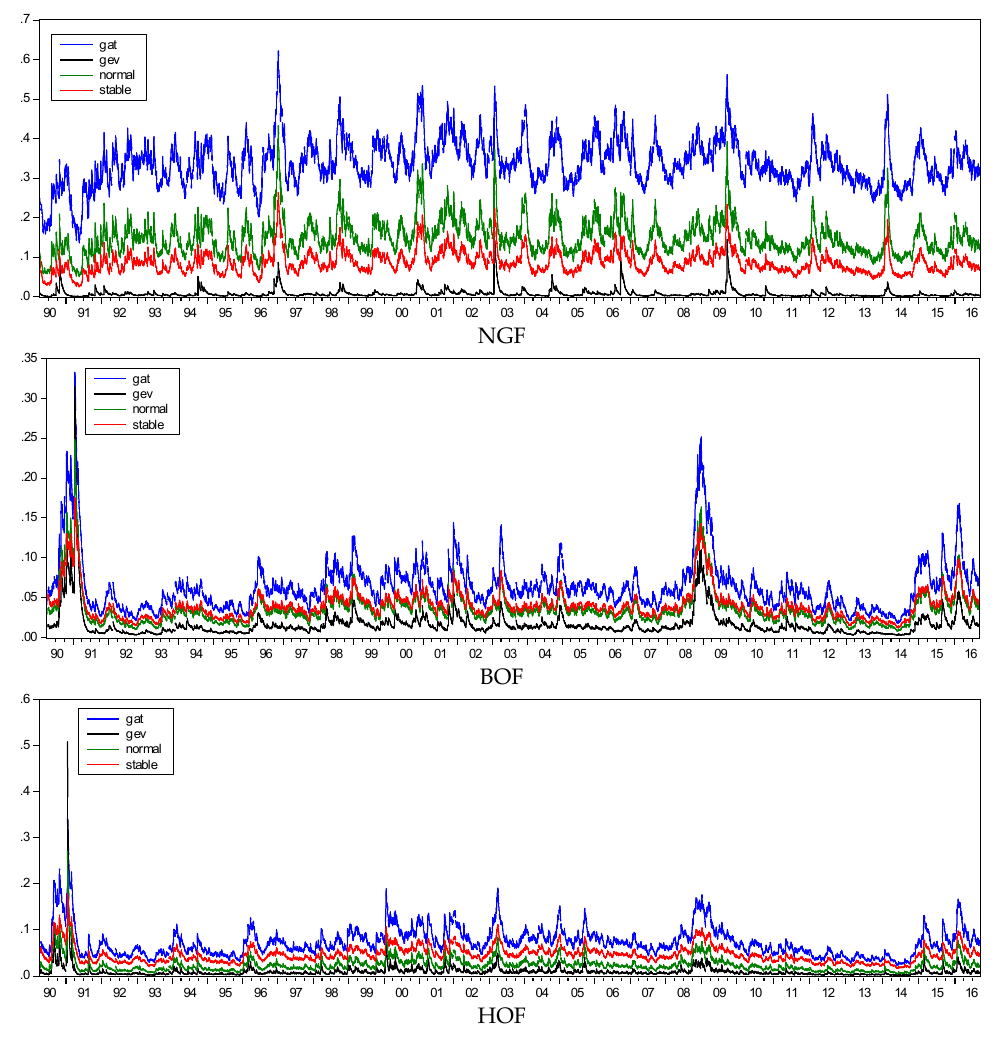
Figure 3. Conditional Volatility of Return Series.